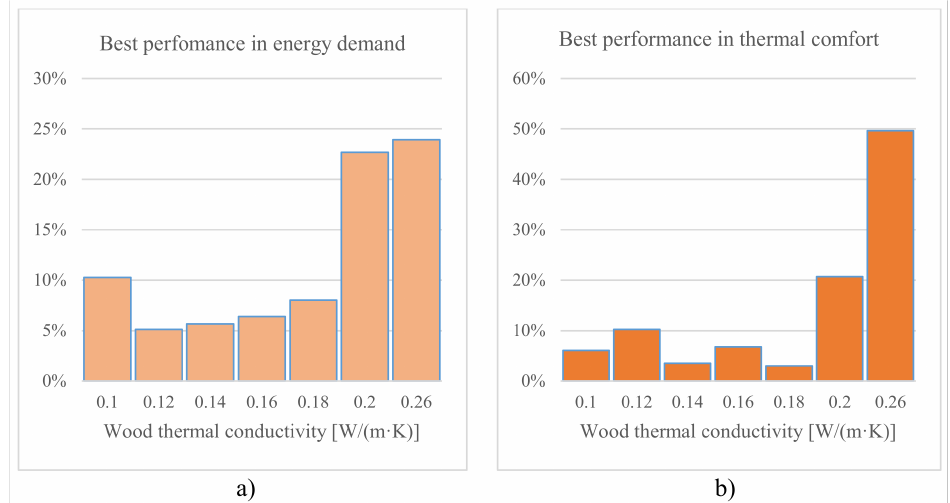
Figure 9. Percentage of cases in which each conductivity range was identified with ( a ) the lowest energy demand while meeting the minimum comfort requirement and ( b ) the greatest number of comfort